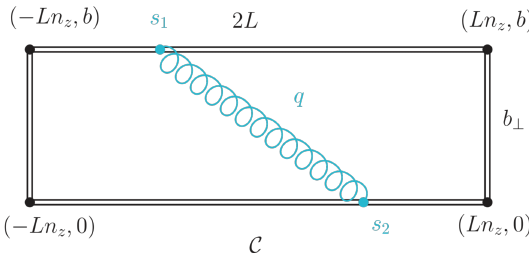
Figure 10 . One-loop diagrams for the Wilson loop. The coordinates s 1 and s 2 of gluon propagators are at any point on the Wilson loop. This includes self-energy, real corrections, and virtual